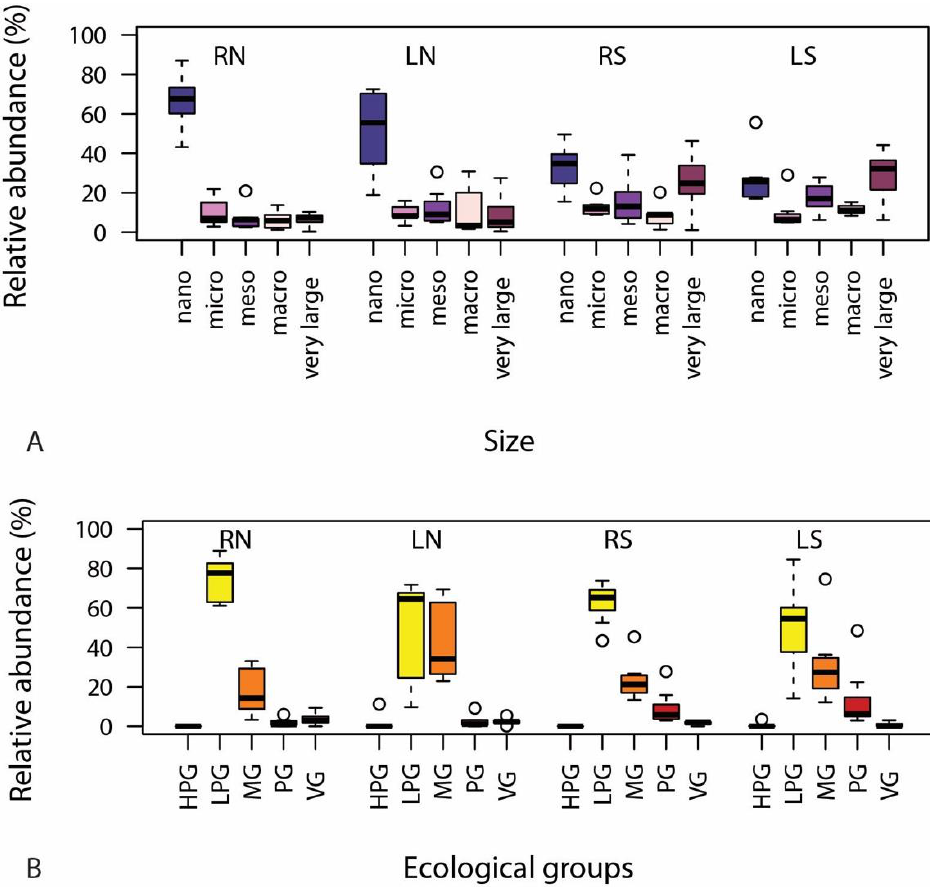
Figure 8. Boxplots illustrating relative abundances of size classes and ecological groups in samples from the four sampling points. Abbreviations: HPG = high profile group, LPG = low profile group, MG = motile group, PG = planktic group, VG = variable group.